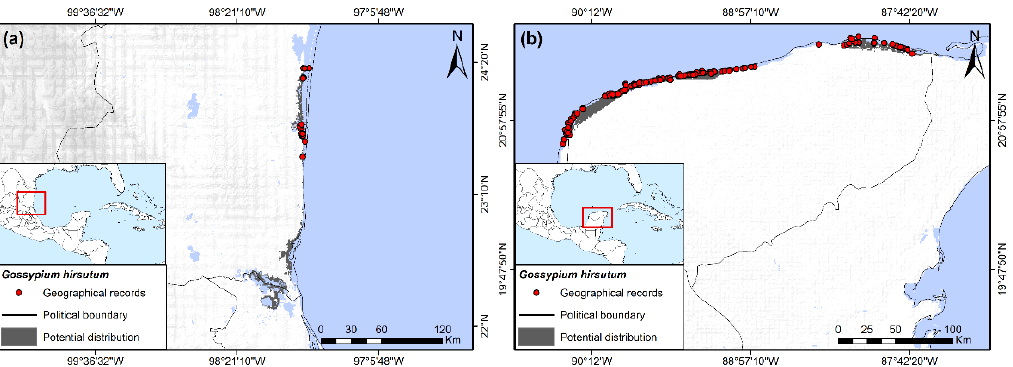
Figure 3. Potential distribution of truly wild Gossypium hirsutum , ( a ) Overall distribution along Atlantic coast in South Tamaulipas and northern Veracruz, Mexico; ( b ) Yucatan Peninsula, Mexico (based in part on data from [29]).